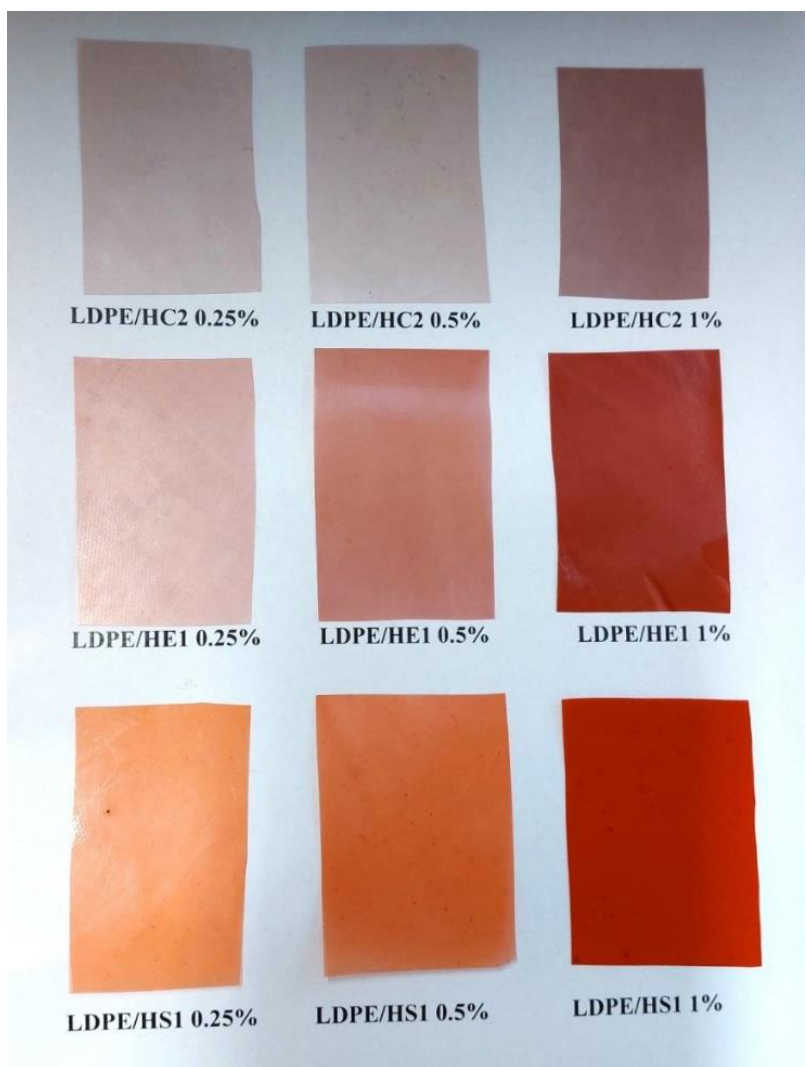
Figure 1. Prepared foils of LDPE/hematite composites.